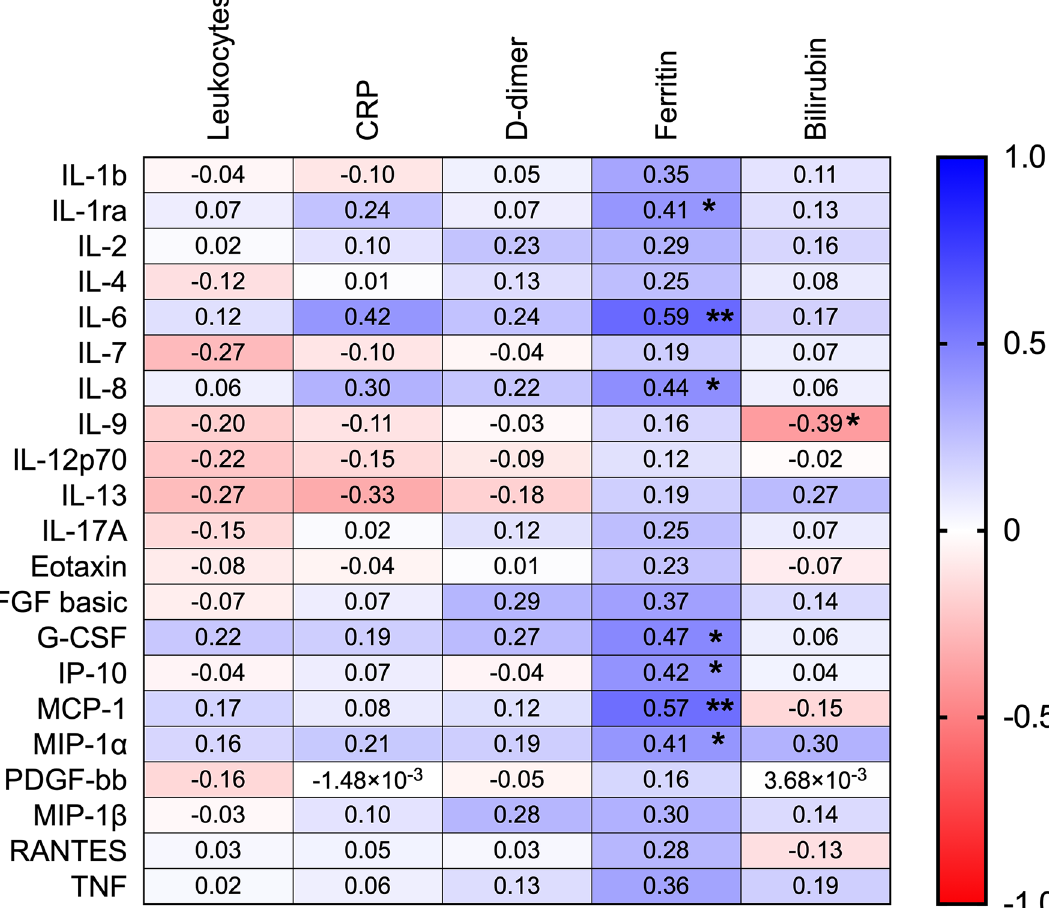
Figure 4. Correlation between biochemistry/hematology parameters and Cytokines. Table displaying Rho values from correlation analysis. Plasma cytokine levels were correlated to leukocyte count (10 9 /L, n = 29), CRP (mg/L, n = 29), D-dimer (n = 23), ferritin (μg/L, n = 29) and Bilirubin (μmol/L, n = 25). Correlations were calculated with Spearman correlation coefficient. Blue color indicates a positive correlation while red represents a negative correlation. Significant correlations are displayed with *. Significance * < 0.05, ** < 0.01.